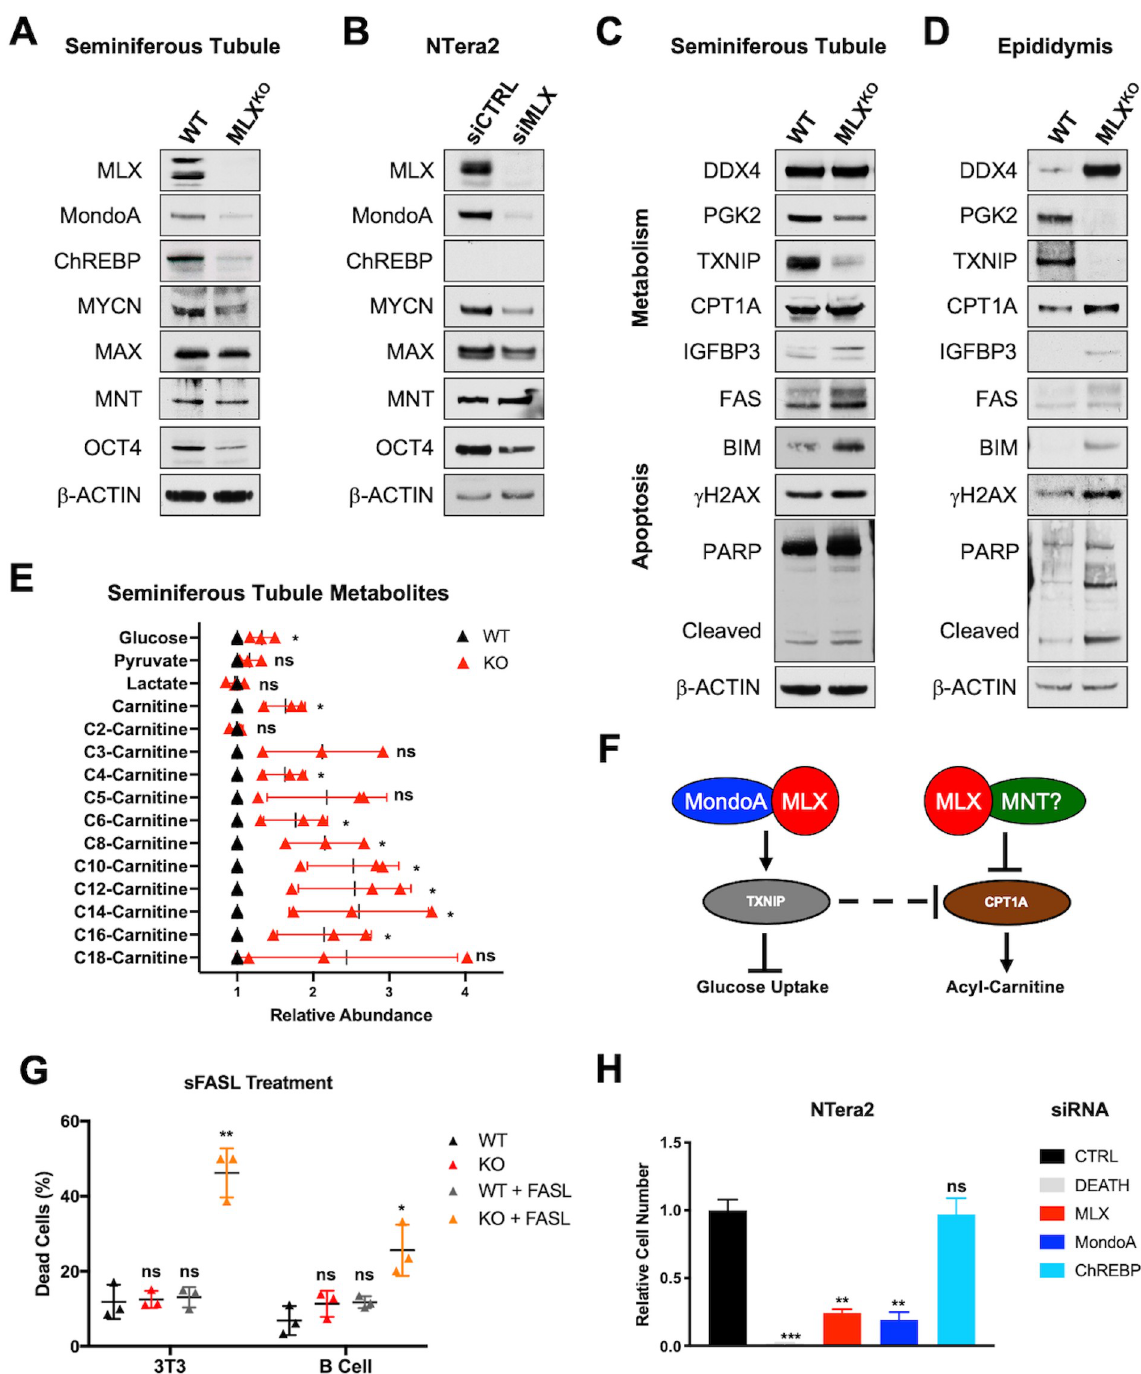
Fig 6. Analysis of DEGs from WT and MLX KO mice. ( A–D ) WB analysis of ( A ) isolated seminiferous tubule cells from WT and MLX KO mice; ( B ) NTera2 MGCT cells treated with siCTRL or siMLX; ( C ) Seminiferous tubule and ( D ) epididymal cells from WT versus MLX KO mice probed for the indicated proteins. ( E ) LC–MS relative abundance data for the indicated metabolites from isolated seminiferous tubule cells ( N = 3 paired littermates, shown is the mean +/ − SD, paired t test). ( F ) Model explaining MLX regulation of metabolic targets. ( G ) sFASL treatment of the indicated cell lines ( N = 3 biological replicates, shown is the percent dead cells with mean +/ − SD). ( H ) Relative viable cell number of the NTera2 cells after siRNA transfection with the indicated siRNA. siDEATH included as control for siRNA transfection efficacy ( N = 4 independent experiments, shown is the mean +/ − SEM). One-way ANOVA with a D AU : PleasenotethatasperPLOSstyle ; testsshouldnotbeinpossessiveform : unnett correction was used for 6G and 6H ( � p < 0.05, �� p < 0.01, ��� p < 0.001, ��� p < 0.0001). The underlying data for Fig 6E, 6G and 6H can be found in S1 Data. DEG,